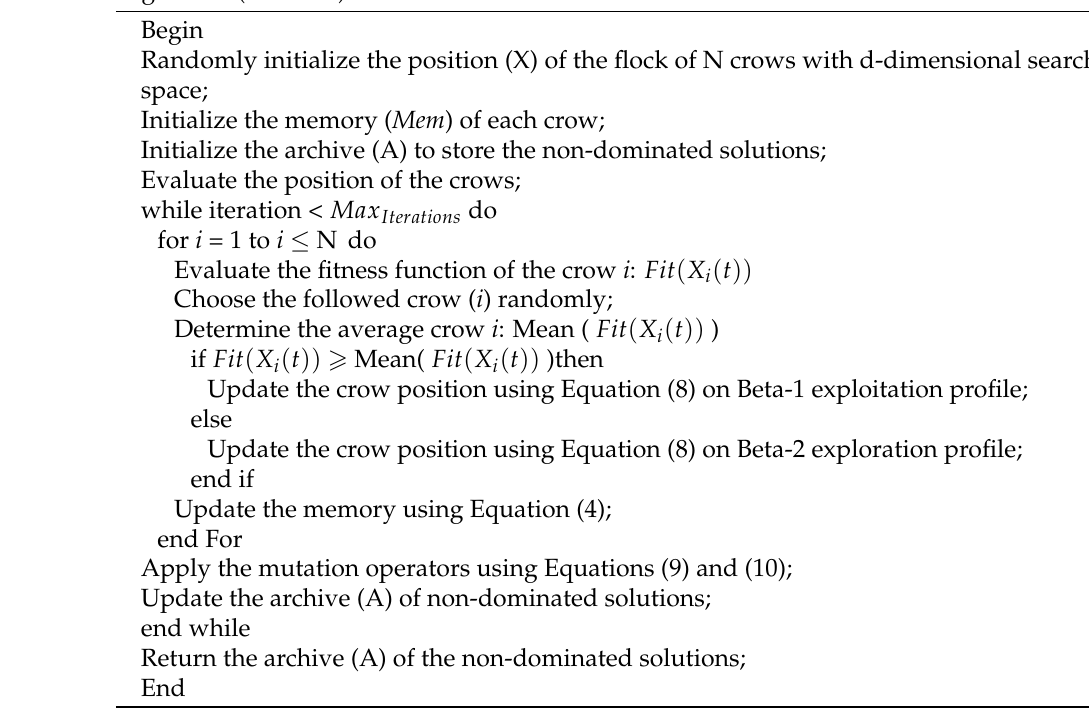
Algorithm 2 The pseudo-code of the proposed Distributed Bi-behaviours Crow Search Algorithm